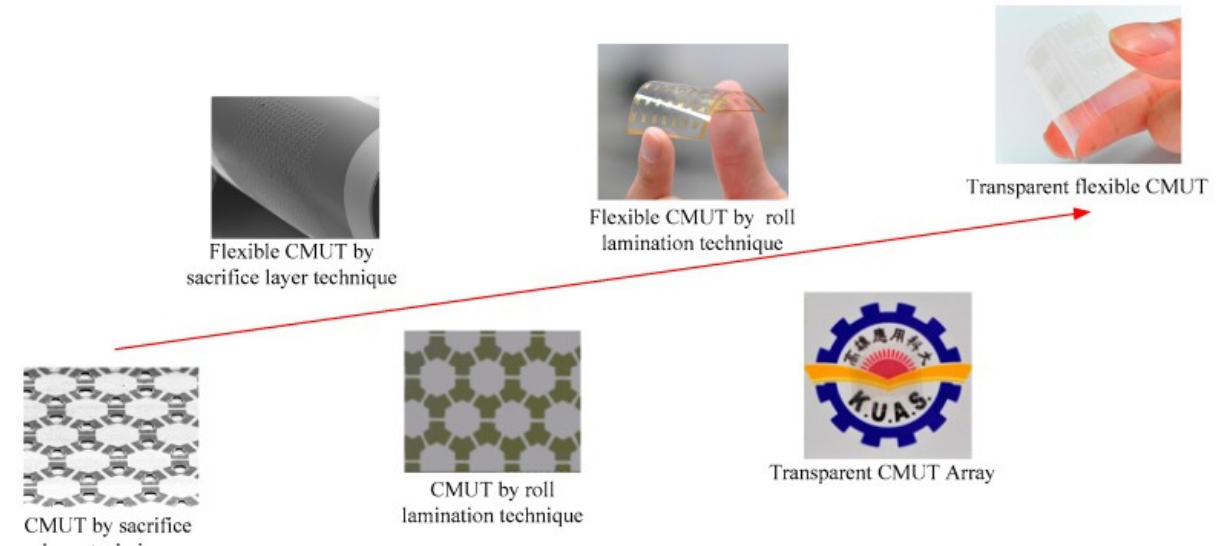
Figure 10. Flexible CMUT step process by Pang et al. [145].